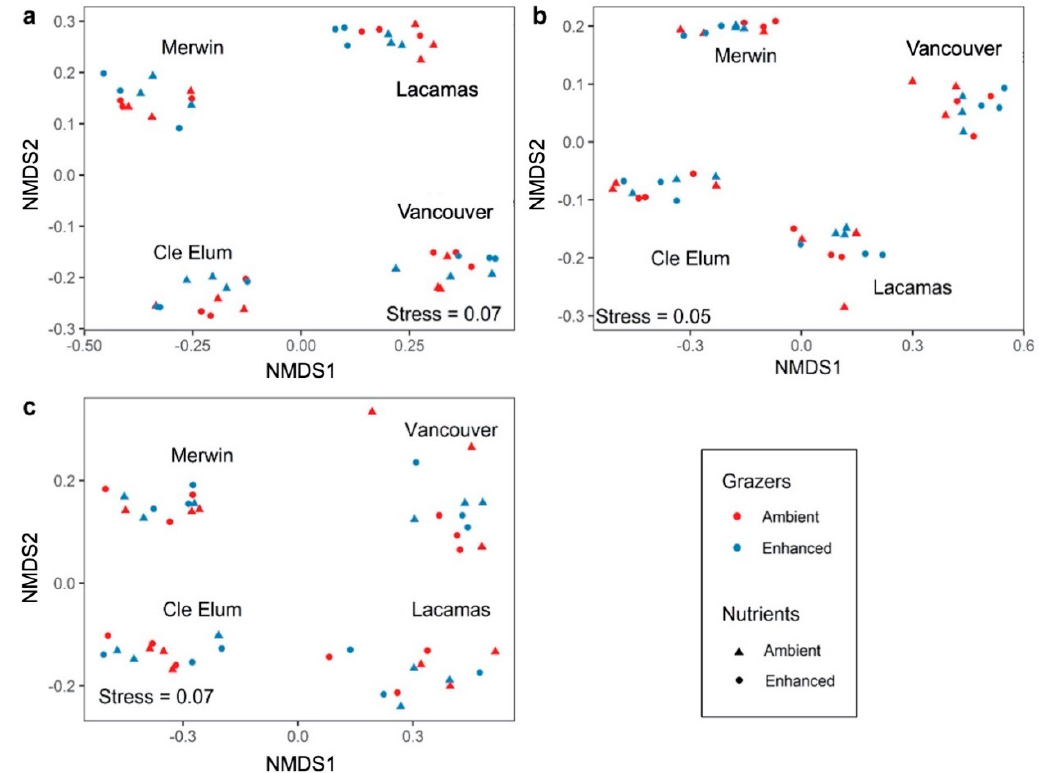
Figure 7. Non-metric Multidimensional Scaling ordination examining relationships between microplankton assemblages in experimental incubations (three control and nine treatment replicates per monthly experiment) for Cle Elum, Merwin, Lacamas, and Vancouver lakes during June, August, and October 2014.